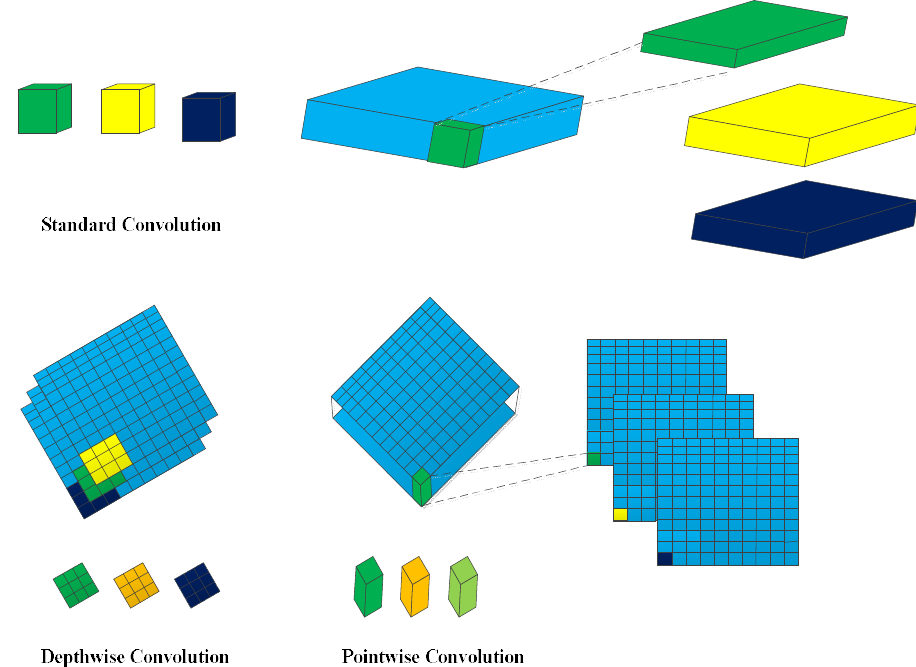
Figure 3. Standard convolutional filters in the top row are replaced by two layers: depthwise convolution in the bottom row, first column, and pointwise convolution in the bottom row, second column.